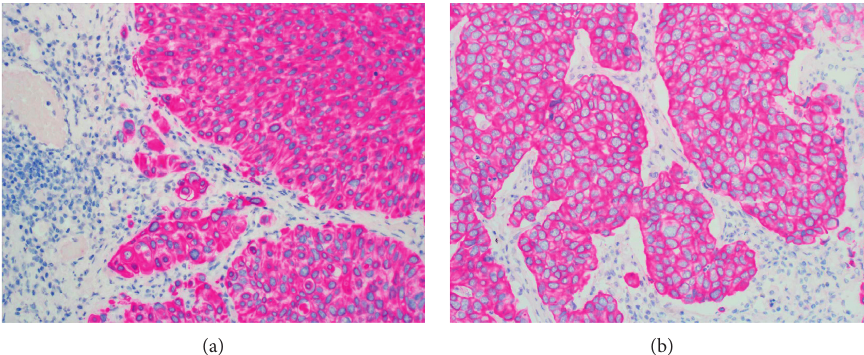
Figure 5: (a) High-grade urothelial carcinoma with early invasion showing strong CK20 cytoplasmic staining and absence of basal cells. (b) High-grade urothelial carcinoma with extensive invasion. The carcinoma cells are diffusely positive for CK20, but the basal layer is absent.